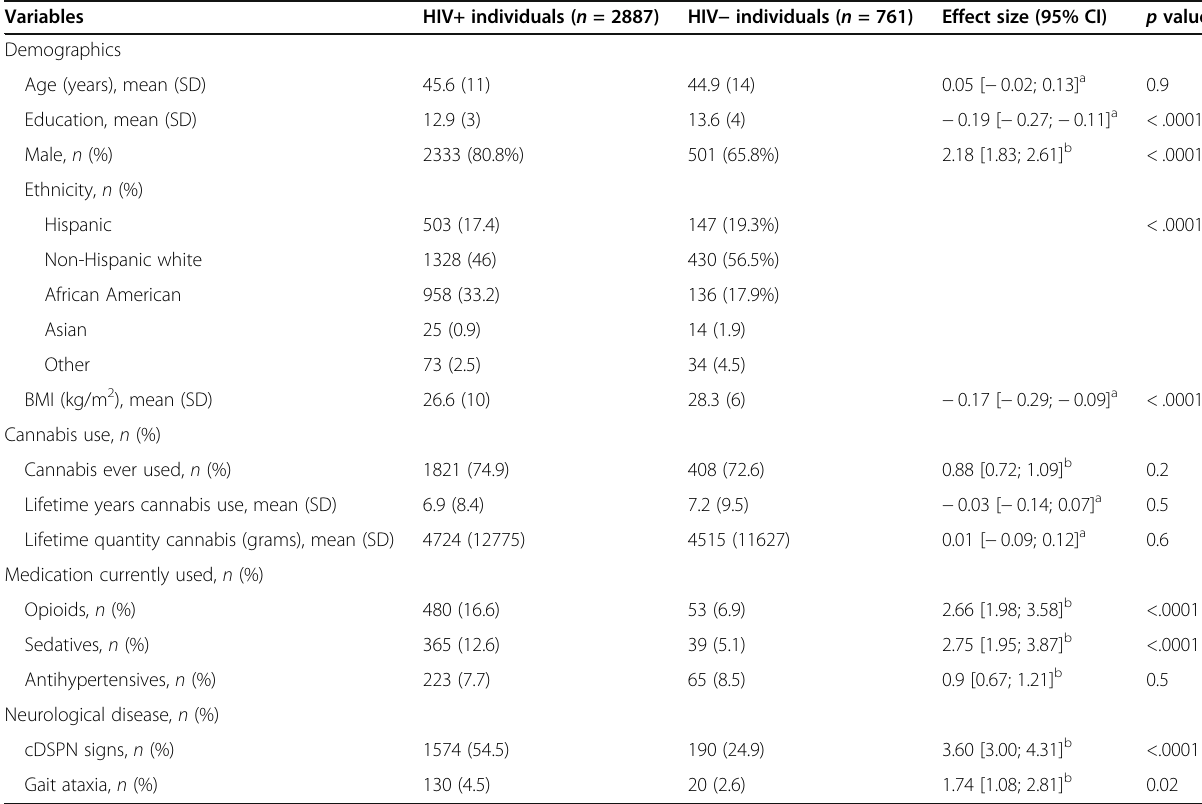
Table 1 Participant characteristics stratified by HIV status